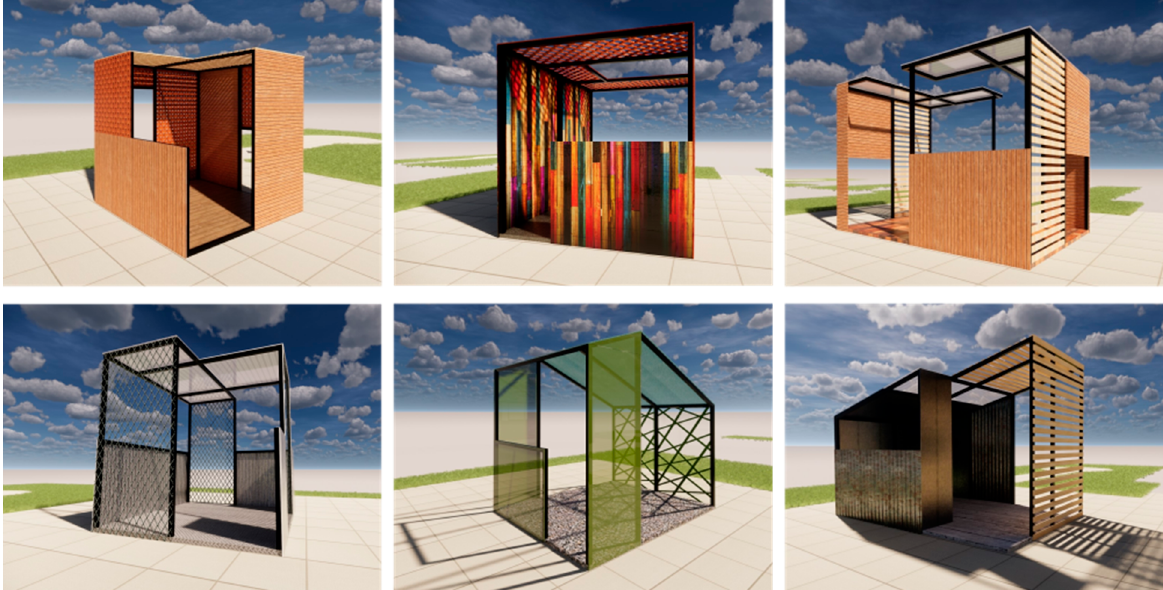
Figure 8. Architectural spaces to be perceived using immersive virtual reality.